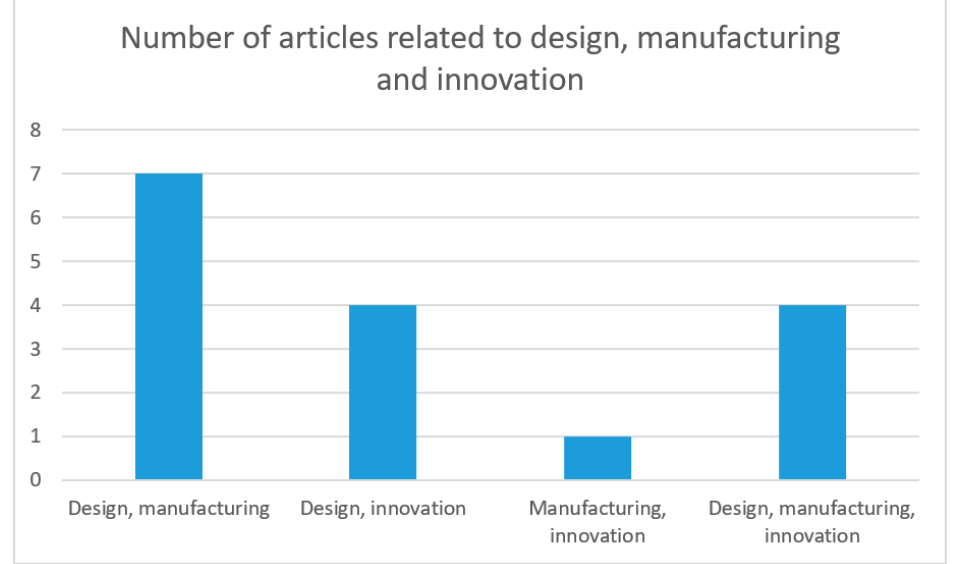
Figure 2. The number of articles demonstrates the relationship between design, manufacturing, product innovation. product